Question: Condense the content of this figure into a single sentence.
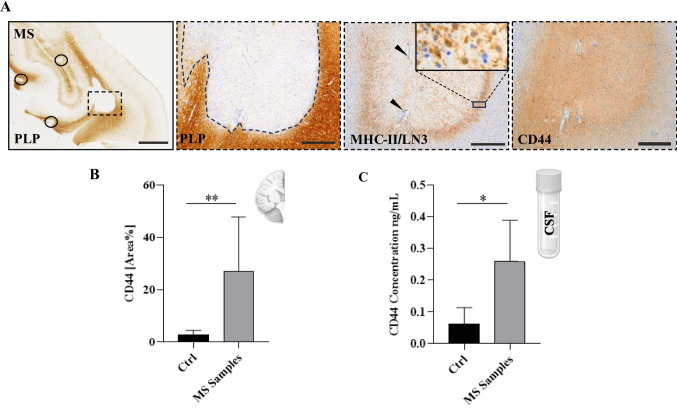
Answer: CD44 in MS postmortem tissues and CSF from MS patients. A Overview of PLP-stained MS brain section with demyelinated lesions (indicated by ellipses and a rectangle). Scale bar: 1 mm. Representative staining (PLP, MHC-II/LN3, CD44) shows immune activation and CD44 expression in lesion areas; The demyelinated areas are marked by dashed black lines; Perivascular cuffs can be identified by arrowheads. Scale bar: 1 mm; insets: 100 µm and 50 µm. B Quantification of CD44 density in control (Ctrl) vs. MS tissue using Mann–Whitney test. Data are mean ± SEM; significance indicated (*p ≤ 0.05, **p ≤ 0.01). C Quantification of CD44 levels in CSF from Ctrl vs. MS patients using Student’s t-test. Data are mean ± SEM; significance indicated (*p ≤ 0.05)